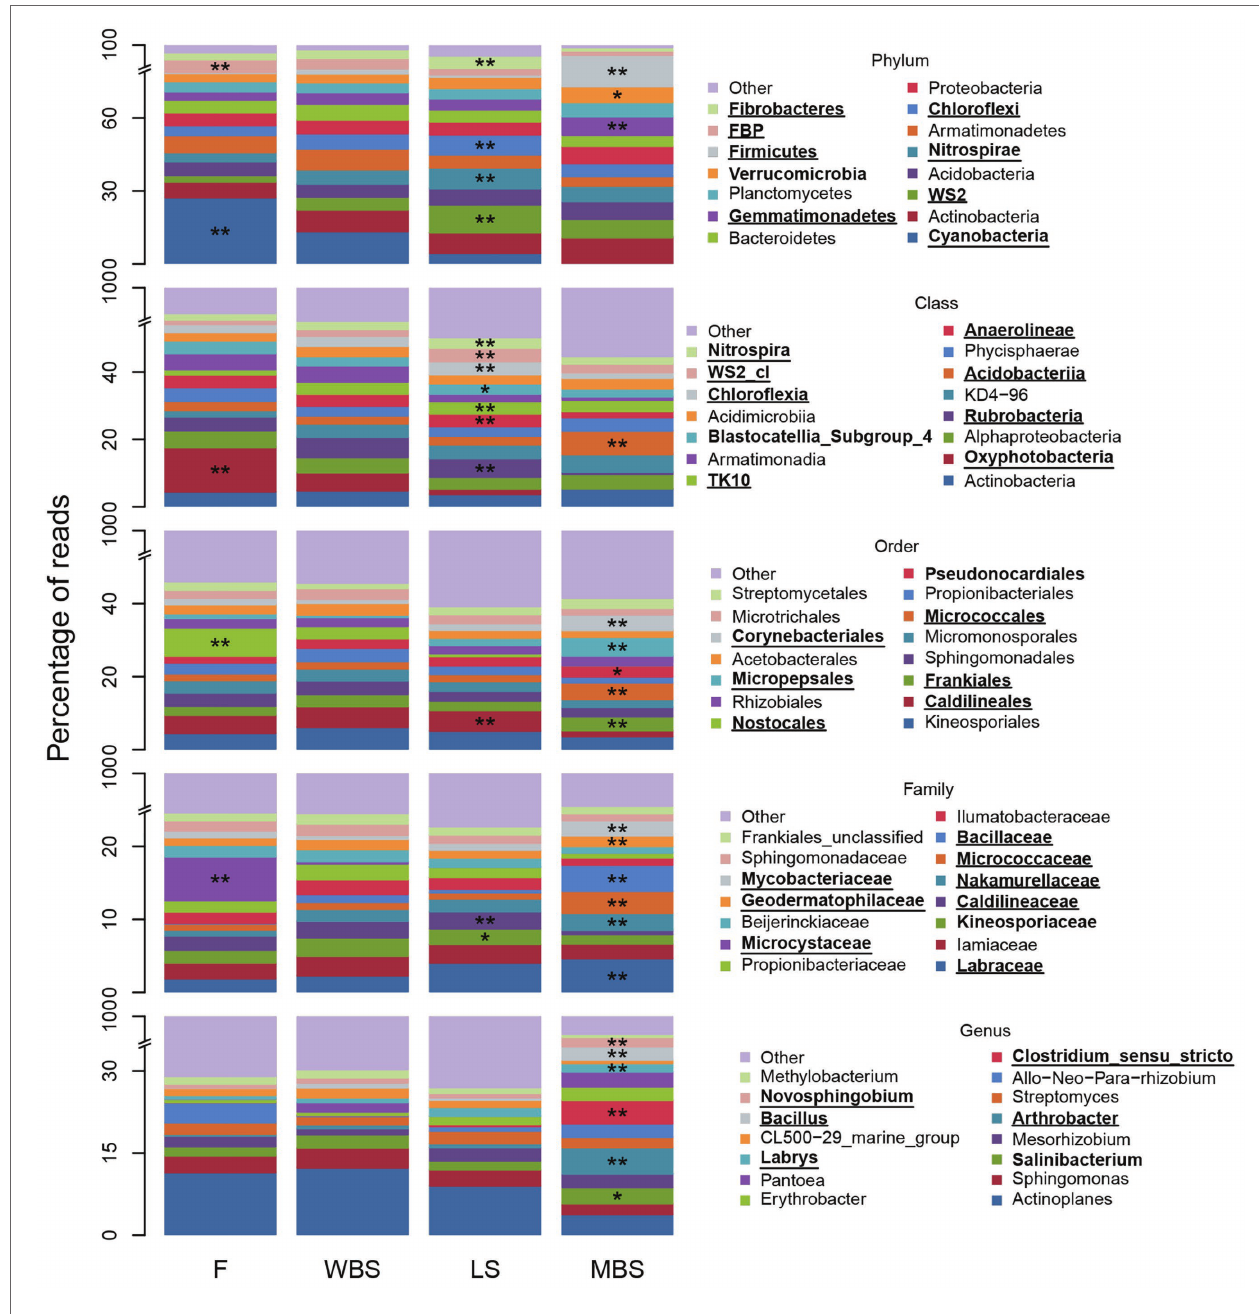
FIGURE 6 | Fifteen most abundant BSC bacterial taxa and indicators, at positions along the elevational gradient. The “other” category comprises all other less abundant taxa and “unclassified” and “uncultured” groups. Asterisks (*) denote a significant indicator species analysis (ISA) taxon and are accompanied by bold font entries in the legend. Double asterisks (**) denote a significant ISA taxon after controlling for false discovery rate (FDR) and are accompanied by bold text and underlined entries in the